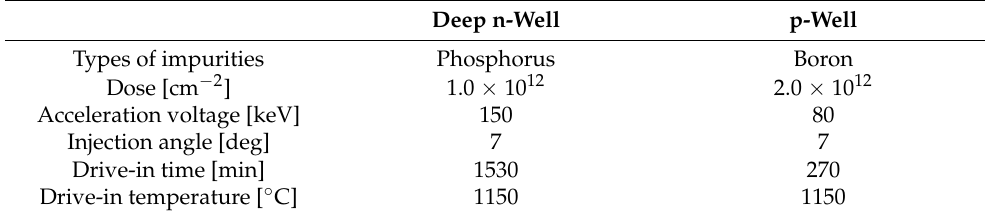
Table 1. Ion implantation